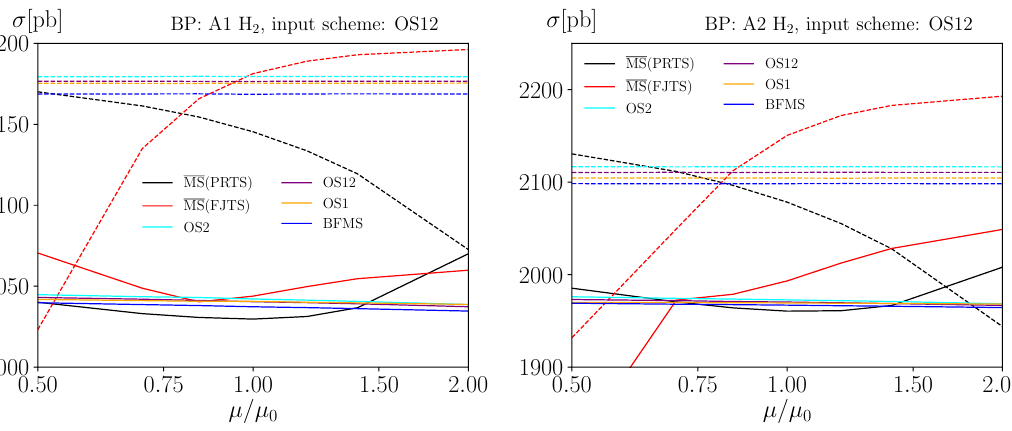
Figure 8 . Scale dependence for light-Higgs-boson production in VBF, pp THDM benchmark scenarios A1 (left) and A2 (right) in di(cid:11)erent renormalization schemes, with the OS12 scheme as input scheme (and full conversion of the input parameters into the other schemes). LO results are shown as dashed, NLO as full lines; the central scale is set to (cid:22) 0 = ( M H + M H + M A + 2 M ) = H + 2 1 0